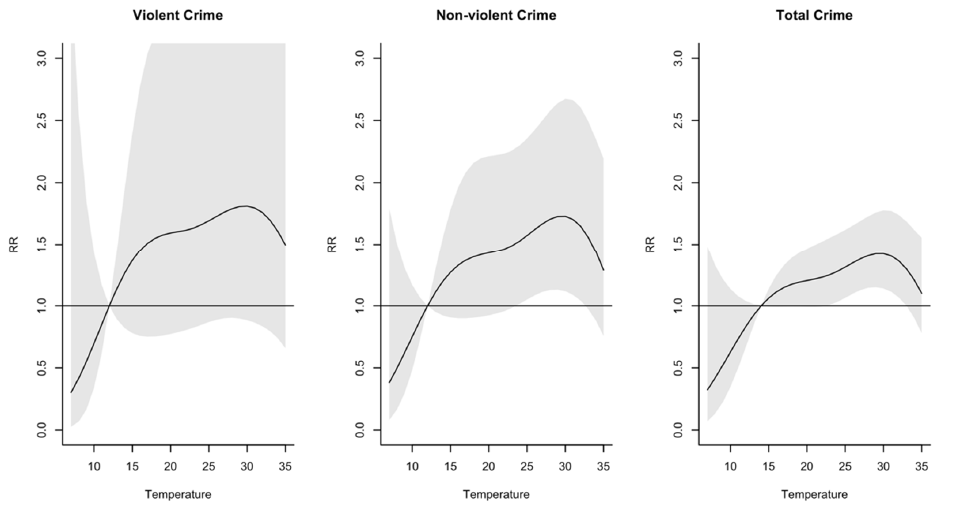
Figure 1. Overall exposure-response associations between daily mean temperature and violent crime (left), non-violent crime (middle), and total crime (right) in urban Hanoi, Vietnam, 2013–2019. The models represent distributed lag curves and shaded areas denote 95% confidence intervals.